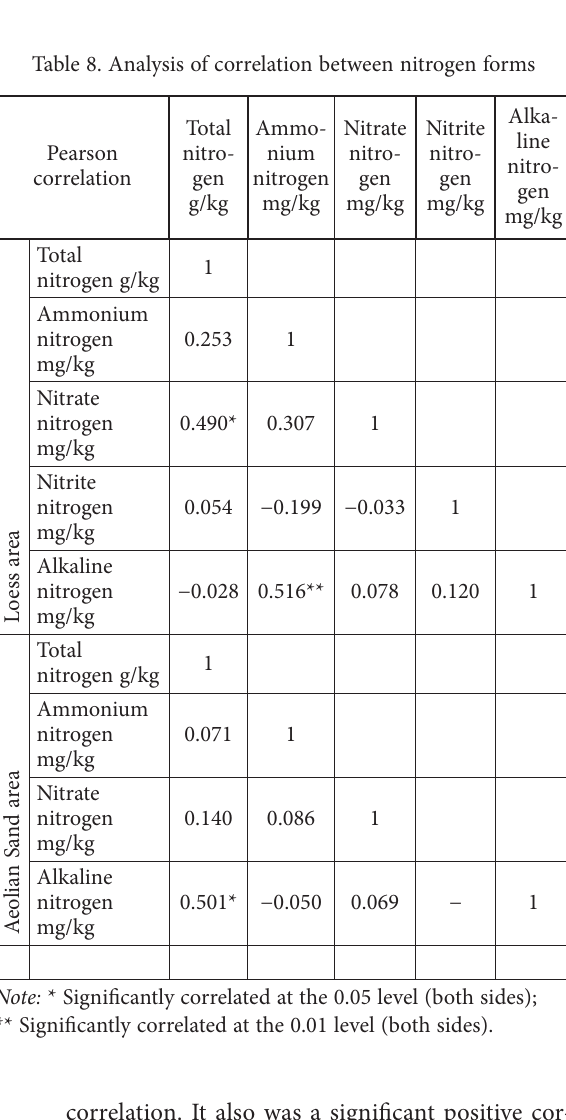
Table 8. Analysis of correlation between nitrogen forms